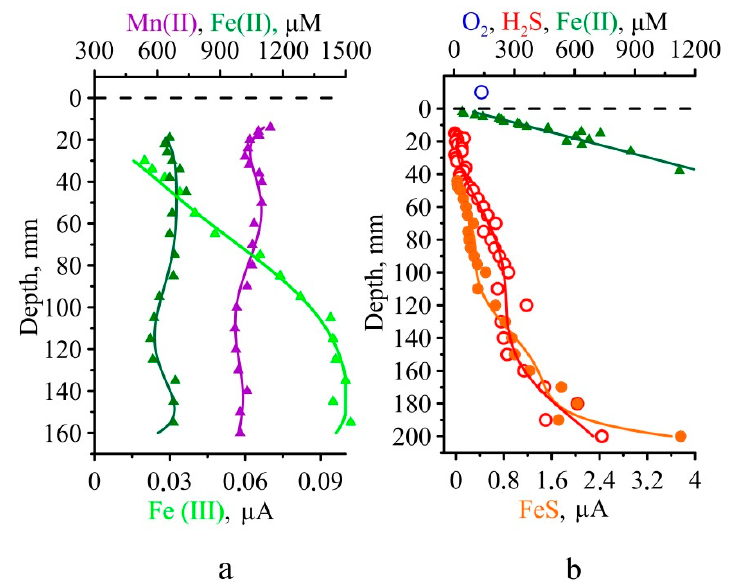
Figure 3. Vertical distribution of pore water components of bottom sediments in the northwestern region: ( a ) St. 12.1; ( b ) St. 158.